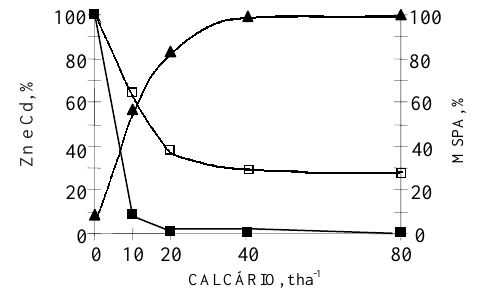
Figura 4. Teores relativos de Zn ( ) e Cd ( ) e maté- ria seca relativa da parte aérea ( ) de mudas de Eucalyptus camaldulensis em solo com con- taminação severa e doses crescentes de calcário. Em relação aos teores relativos de Zn e Cd, sem calcário = 100 %, e quanto à matéria seca relati- va da parte aérea, 80 t ha -1 de calcário = 100